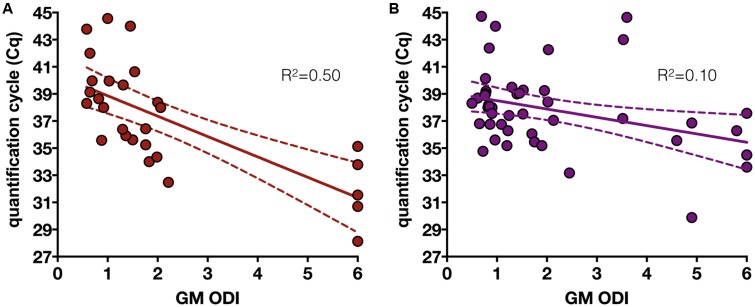
Correlation between galactomannan index (GM-ODI) and quantification cycle (Cq) of Aspergillus fumigatus PCR assay in GM-positive serum samples obtained before (A) or after (B) initiation of antifungal therapy.